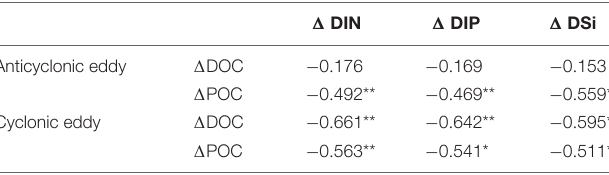
TABLE 2 | Correlation between biochemical modulated organic carbon and